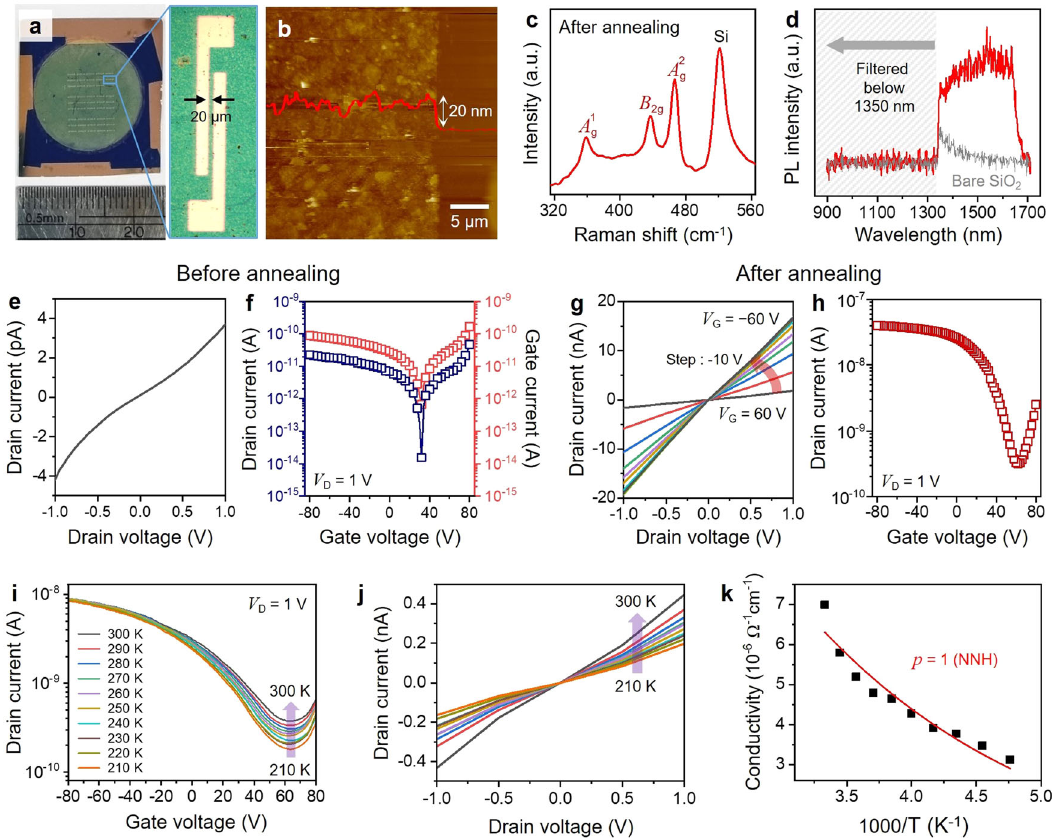
Fig. 2 Effect of annealing process on the electrical properties of the BP transistor. a Photograph of the BP transistor array. Zoomed-in optical microscope image shows a single device. AFM image at the boundary between the annealed BP thin fi lm and bare substrate regions. The fi lm thickness is about 20 nm. c Raman spectrum of the BP thin fi lm after annealing. d Photoluminescence spectrum of the annealed BP thin fi lm. Spectral region with wavelengths shorter than 1350 nm was fi ltered to remove signals from the SiO 2 /Si substrate. e , f Output and transfer curves of the BP transistor before annealing. g , h Output and transfer curves of the BP transistor after annealing. i , j Transfer curves ( V D = 1 V) and output curves ( V = 0 V) at different temperatures from 210 K to 300 K. k Temperature-dependent conductivities of the BP fi lm G determined from the ungated device ( V D = 1